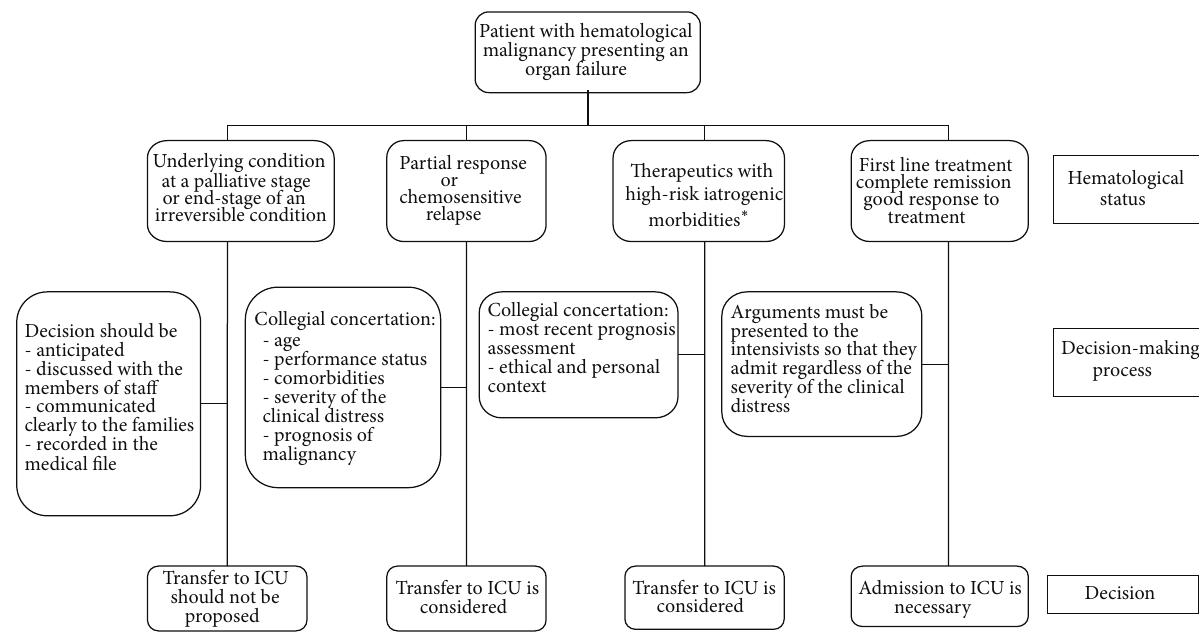
Figure 1: Decision model of ICU transfer of patients with hematological